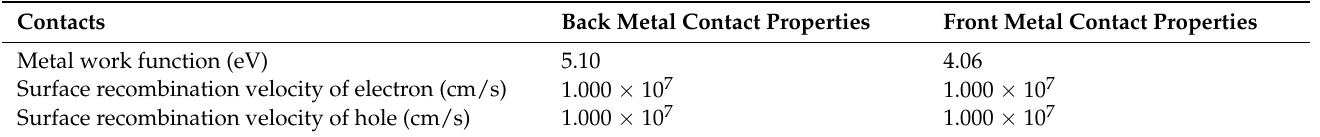
Table 2. Contact parameters used in the simulation.